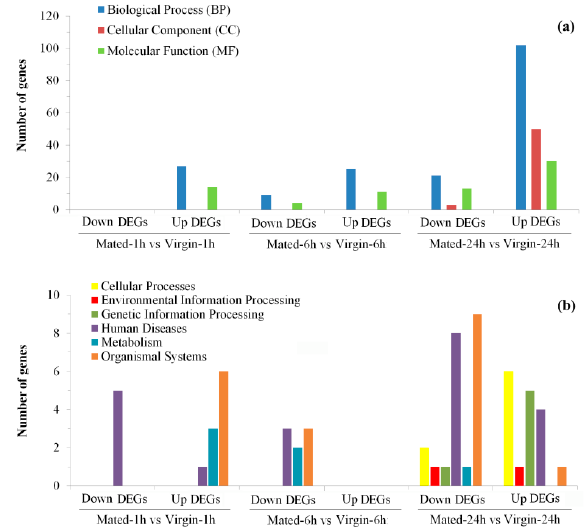
Figure 3. Summary of GO ( a ) and KEGG ( b ) enrichment analysis of DEGs in different groups.